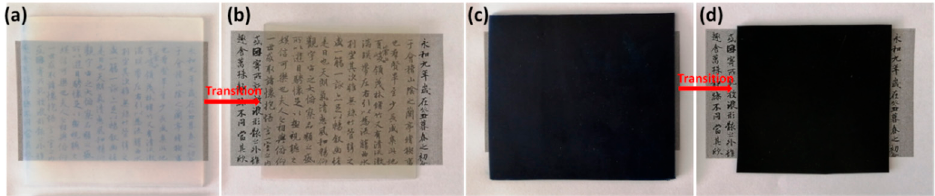
Figure 1. Digital photographs of samples placed on black pattern strip with printed Chinese cal- ligraphy. Cellulose hydrogel ( a ), CBP ( b ), PB@cellulose hydrogel ( c ), and PCBP ( d ).